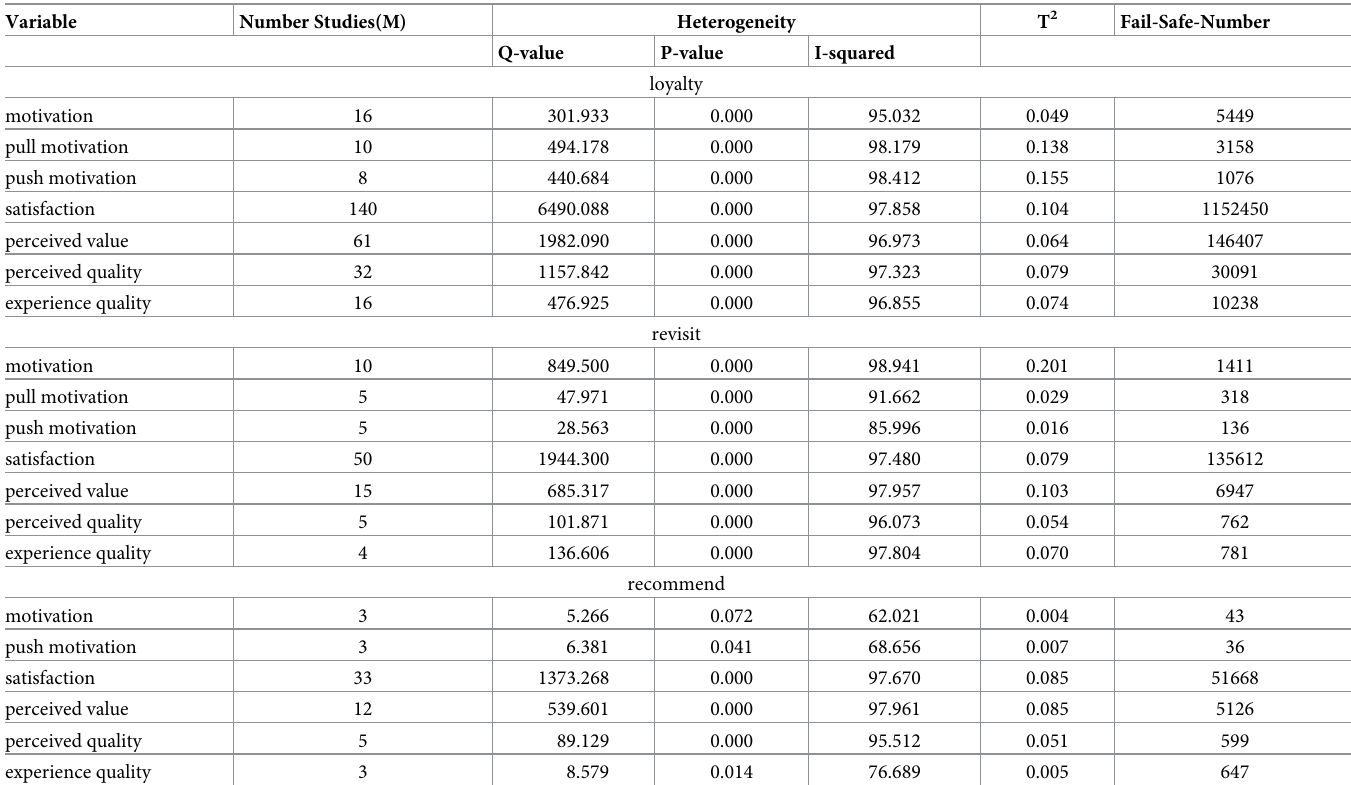
Table 1. Publication bias and heterogeneity